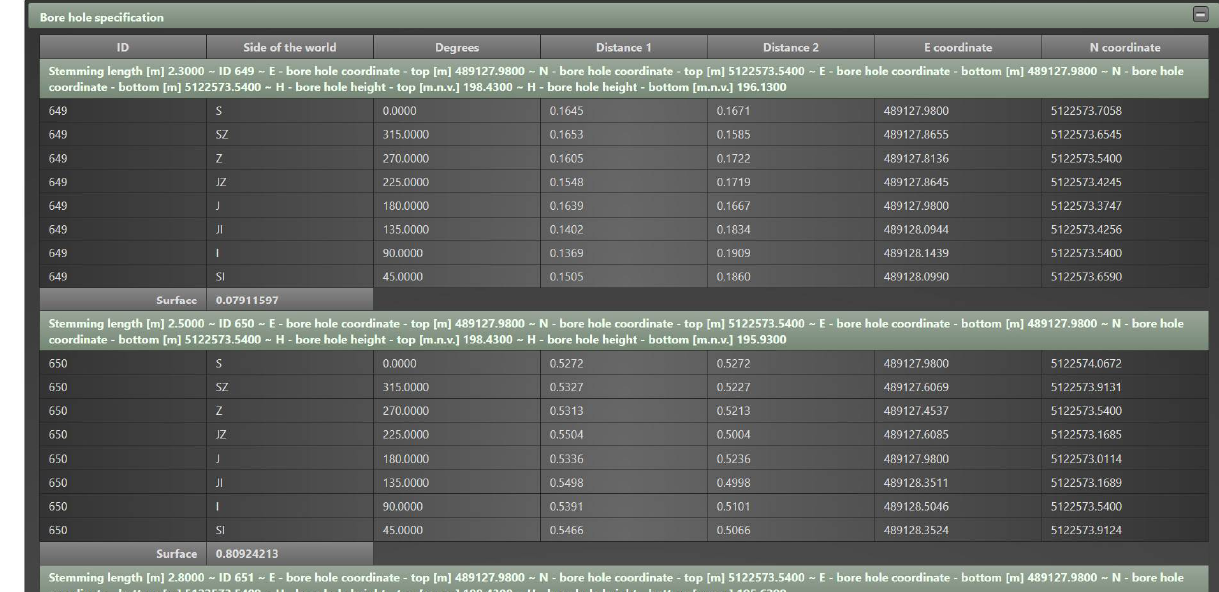
10 of 16 Figure 5. Report example [4]. The application calculates volume in cubic meters, decimeters, and centimeters. Fur- ther, there are options for drawing a 3D model of the selected borehole or the resulting expansion. The application takes all coordinates of all layers depth-wise and draws a 3D model in three ways: dotted 3D model, linear 3D model, and triangulation 3D model. Ad-